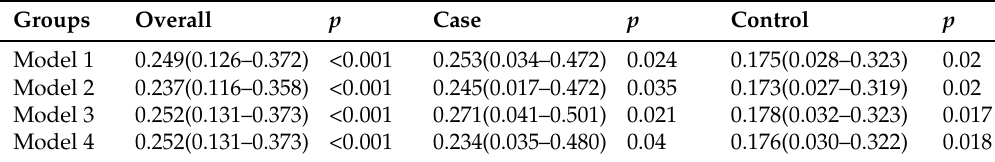
Table 3. The β -Coefficients of serum 25(OH)D and sunlight exposure in the multiple linear regression